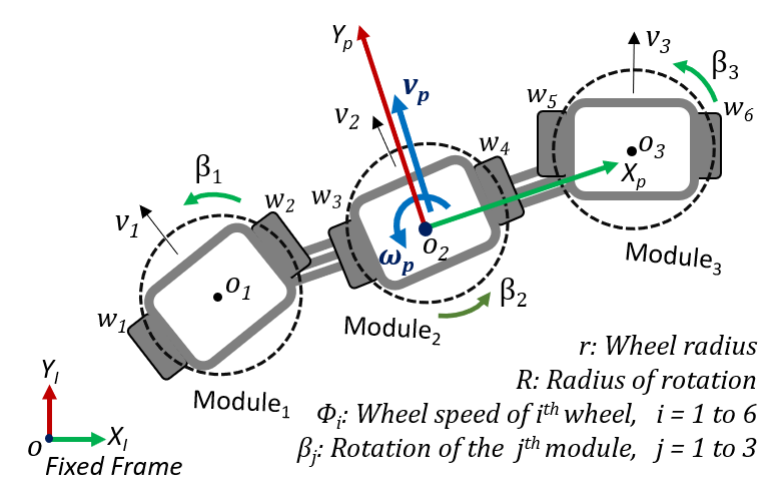
Figure 14. Schematic diagram of the Mantis-mini presenting the wheel layout.